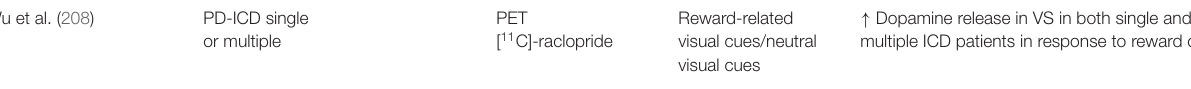
PD-ICD single or multiple